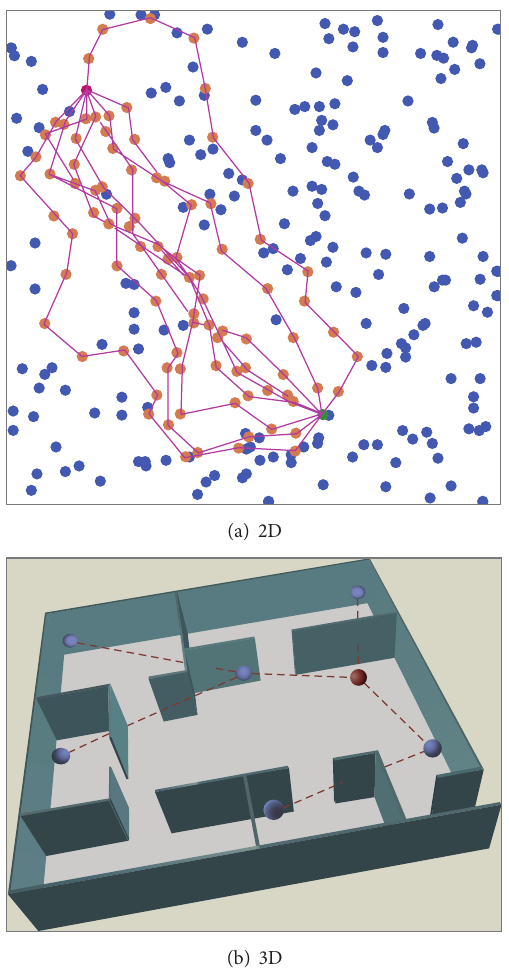
Figure 3: Two-dimensional and three-dimensional space in Net- Topo [71]